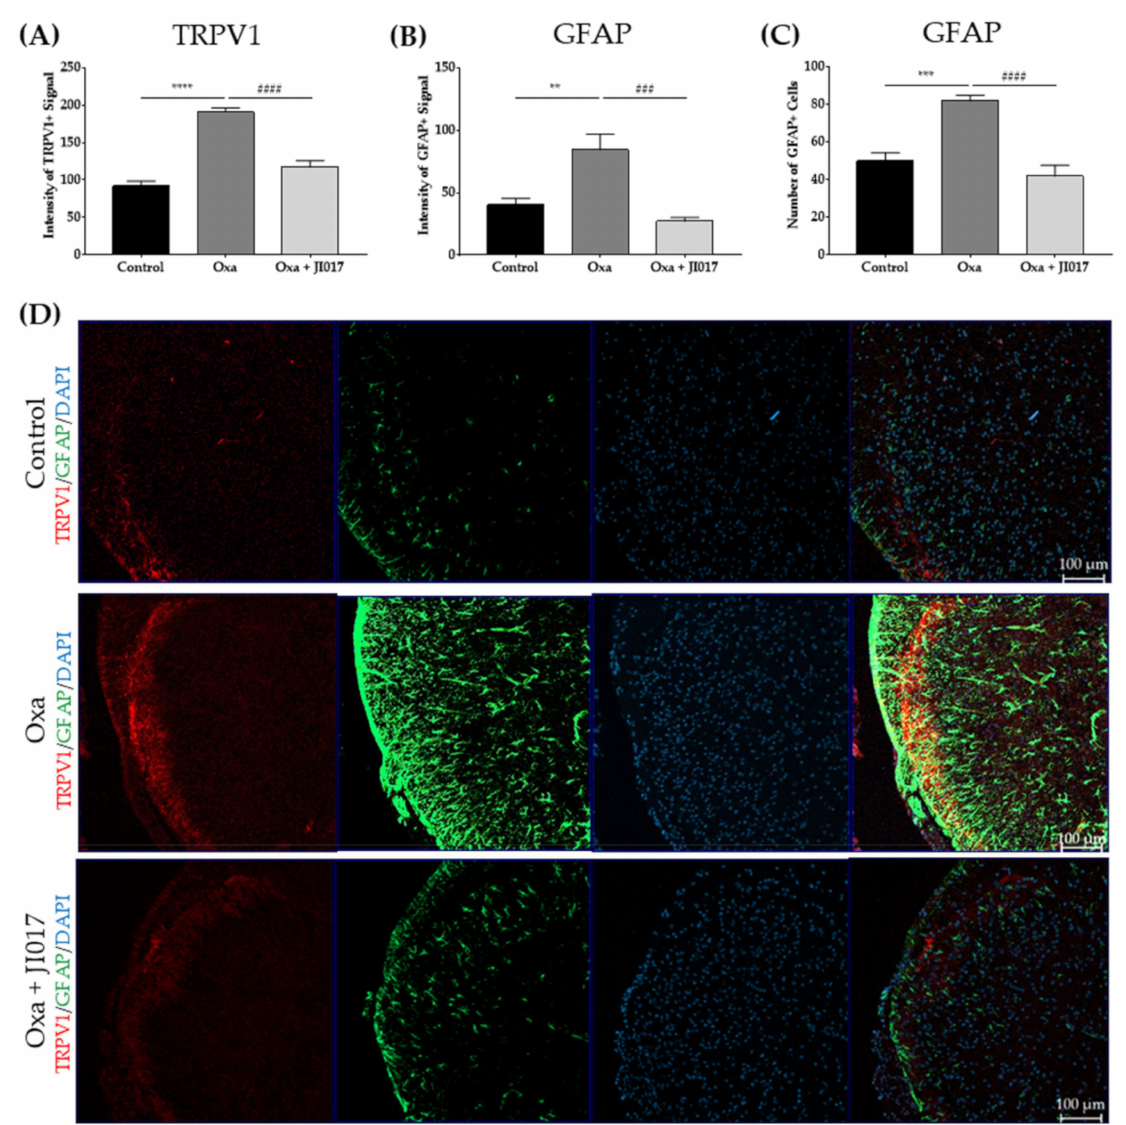
Figure 3. Changes of spinal TRPV1 and GFAP levels after JI017 treatment. On D4 after oxaliplatin injection, spinal TRPV1 and GFAP levels were observed and evaluated. In the oxaliplatin group (Oxa), an increase in spinal TRPV1 and GFAP signal intensity ( A , C ) and in the number of GFAP-positive cells ( B ) were observed. TRPV1 and GFAP signals were attenuated an hour after JI017 treatment (500 mg/kg). Naïve mice were used as controls ( A , B ). Mice of the Oxa group that were administered PBS were considered as the control of JI017. Representative images from each group were presented. The fourth image in each row represents the merge of the three images on the left ( D ). Control: n = 6, Oxa: n = 6, Oxa + JI017: n = 6. ** p < 0.01, *** p < 0.001, **** p < 0.0001 vs. control, ### p < 0.001, #### p < 0.0001 vs. Oxa, with one-way ANOVA followed by Tukey’s post-test for multiple